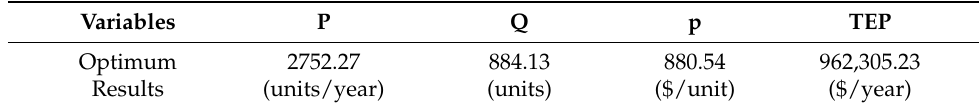
Table 6. Optimum outputs for the case without service facilities.